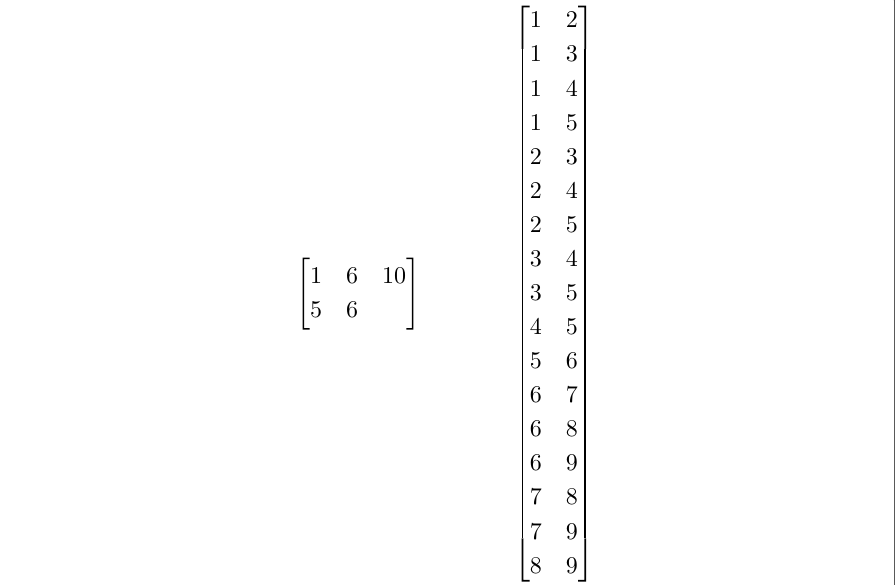
Fig. 3 GraphZIP compressed format (left) vs. edge list without clique compression (right)